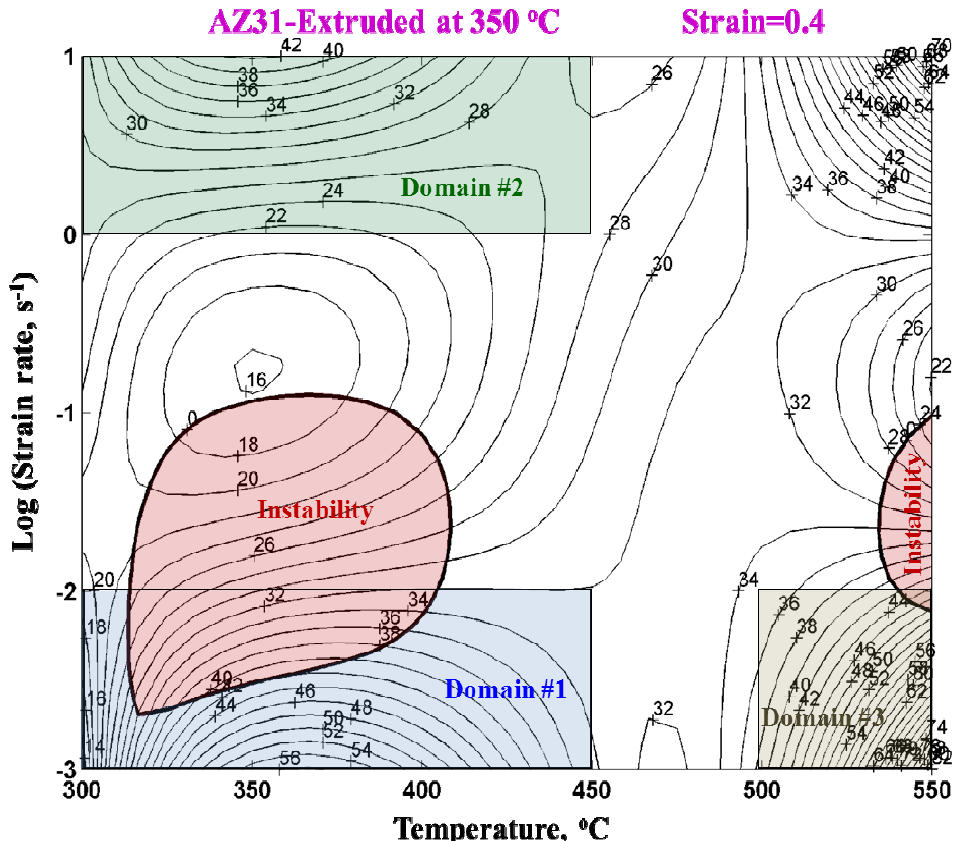
Figure 8. Processing map obtained at a strain of 0.4 for AZ31 magnesium alloy extruded at 350